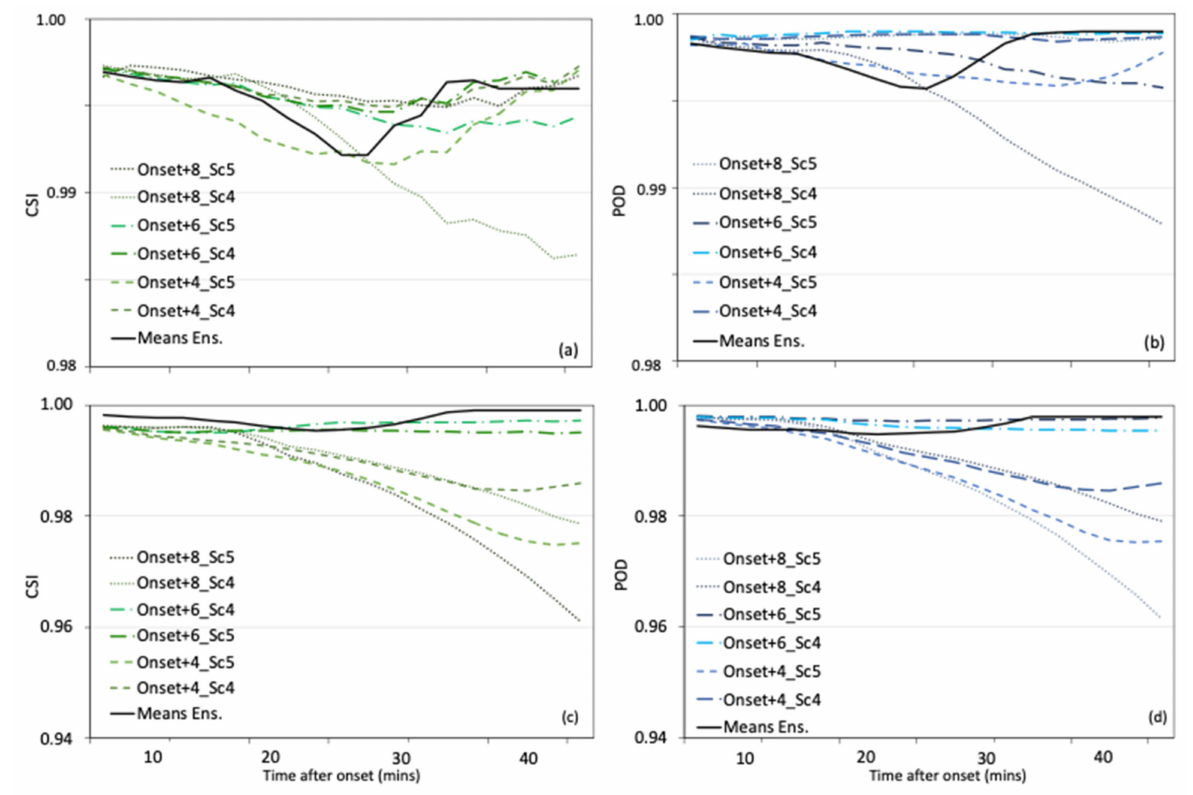
Figure 8. Spaghetti plots of CSI ( left ) and POD ( right ) for both study cases. ( a , b ) M05 and ( c , d ) M06. The ensemble member was named based on IC: onset+ i _Sc j , where i and j represent the time in minutes and advection phenomena (Table 2), respectively.